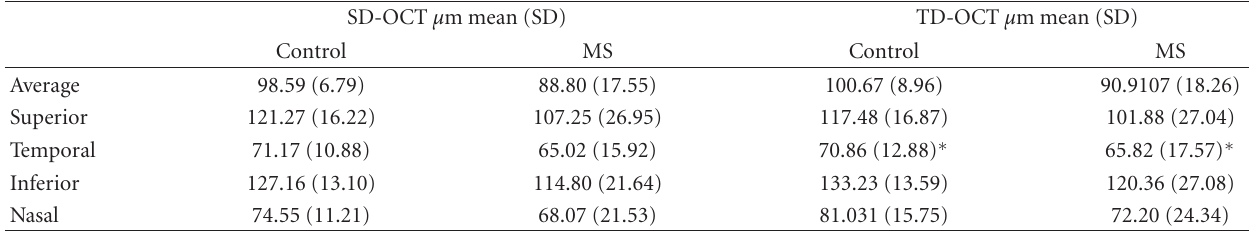
Table 3: Overview RNFLT between SD- and TD-OCT in MS and control groups, separated by quadrants.